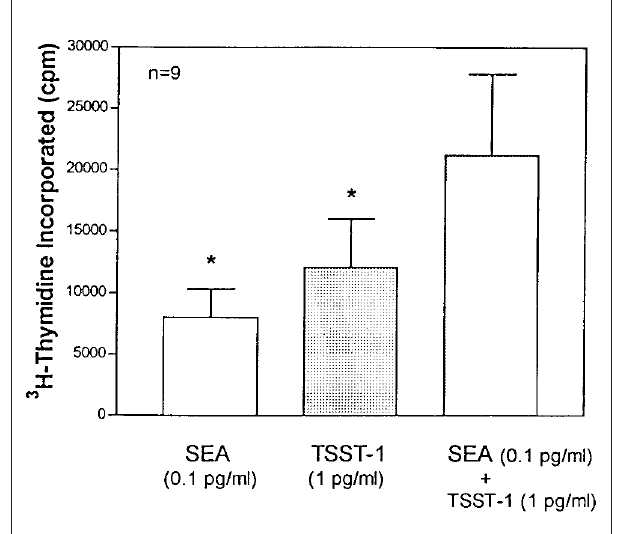
Figure 2) Mitogenic response of human peripheral blood mononuclear cells from nine healthy donors stimulated with toxic shock syndrome toxin-1 (TSST-1) , staphylococcal enterotoxin A (SEA) or their combi- nation for 72 h. Each value is presented as the mean (cid:1) SEM from a minimum of quadruplicate determinations. *Significantly